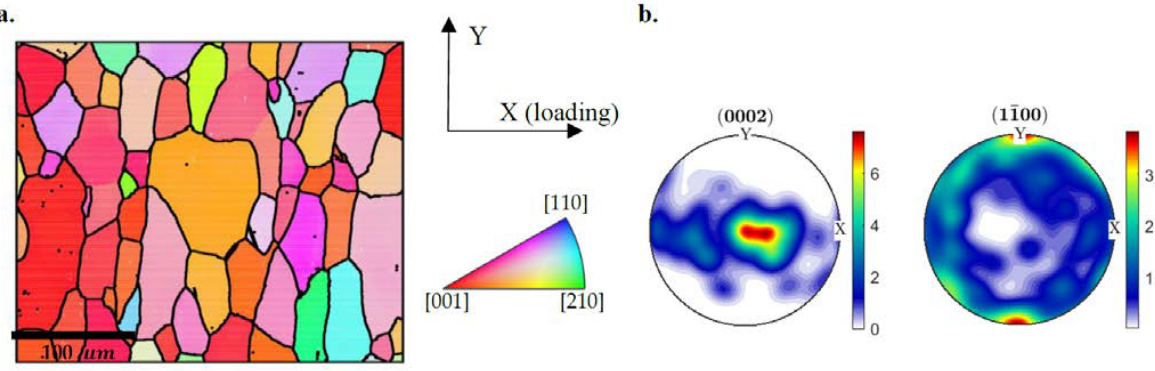
Figure 1. ( a ) An inverse pole figure-Z of the sample with the corresponding pole figure shown in ( b ).